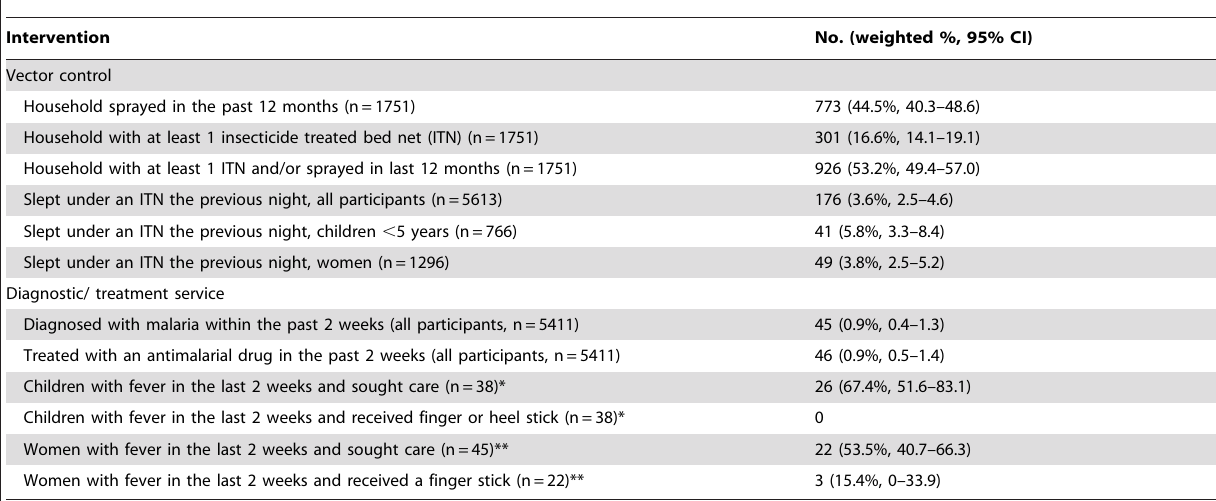
Table 2. Intervention coverage among of survey participants.